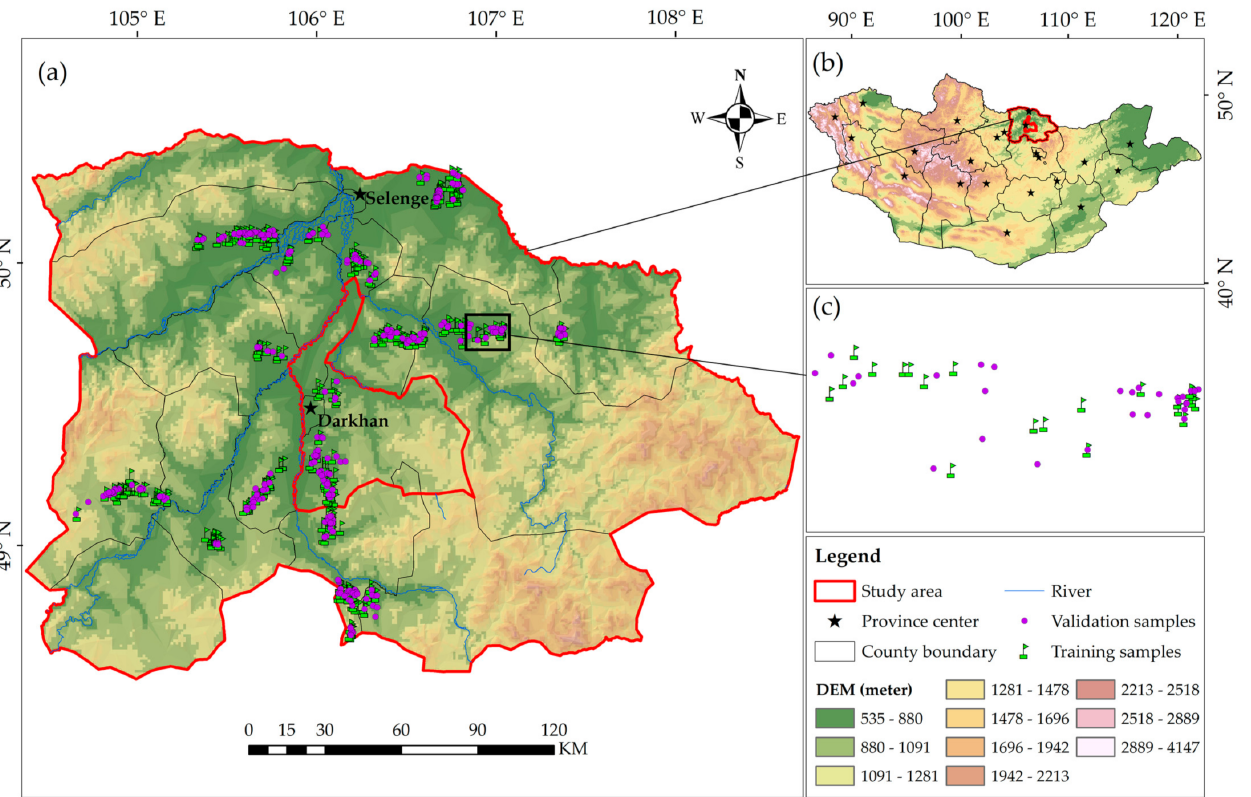
Figure 1. Geographical location of the study area and spatial distribution of collected crop samples ( a ), Digital Elevation Model (DEM) of Mongolia ( b ), and Training and validation samples ( c